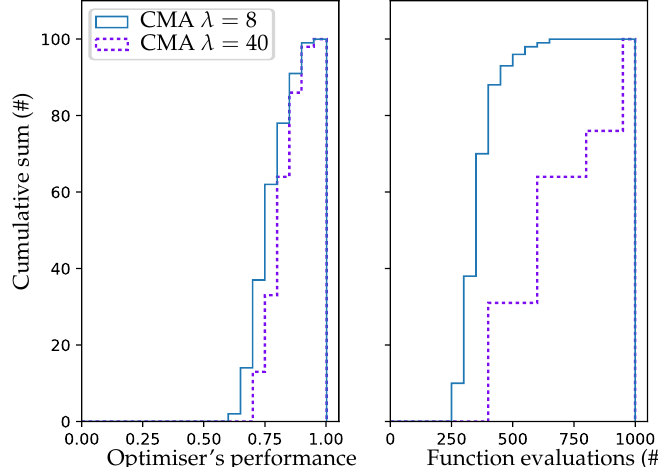
Figure 5. Covariance matrix adaptation evolution strategy’s (CMA’s) performance and required number of function evaluations prior to termination. The results are shown for 100 runs performed using population sizes of 8 and